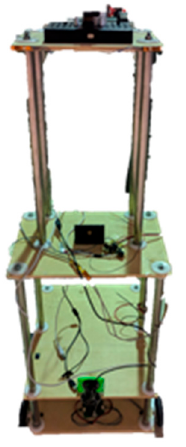
Figure 9. Automated guided vehicle.